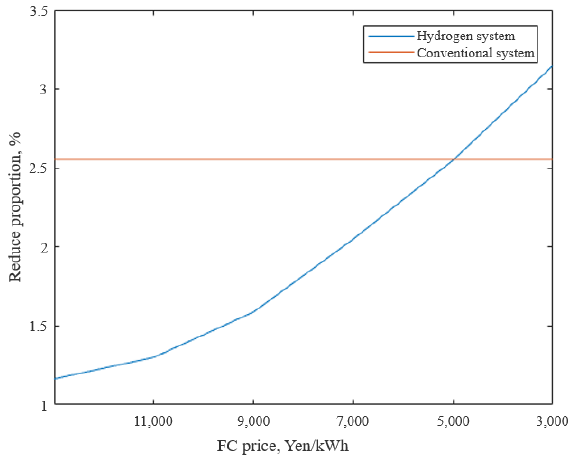
Figure 8. Variation curve of total cost with decrease in FC cost.